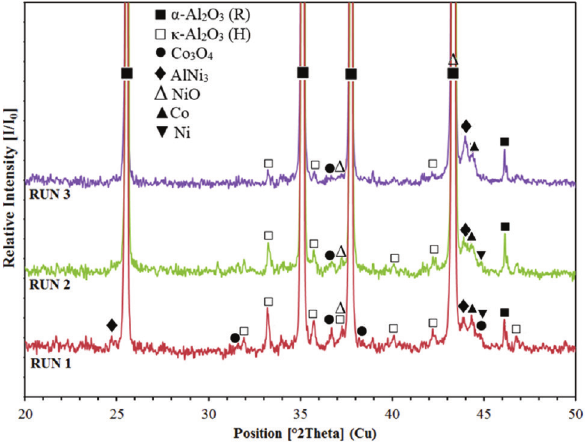
Fig. 6: Effect of gravitational force on total metal recovery and scattered ratio of SHS alloy for estimated composition of